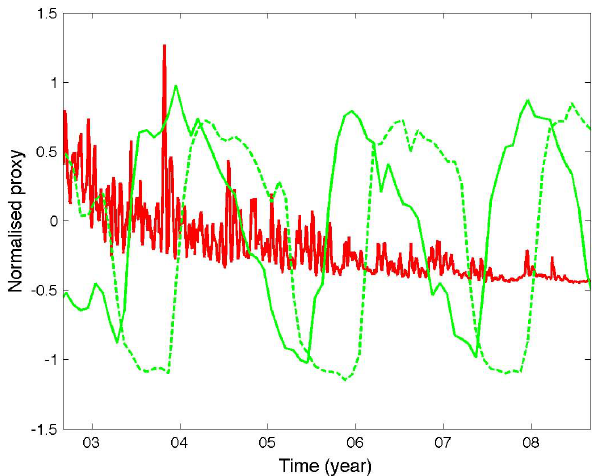
Fig. 3. Normalised daily proxies (see Eq. 3) as a function of time. The solar F10.7cm radio flux (red line) serves a solar proxy. The winds at 10hPa (solid green line) and 30hPa (dashed green line) are proxies for the QBO